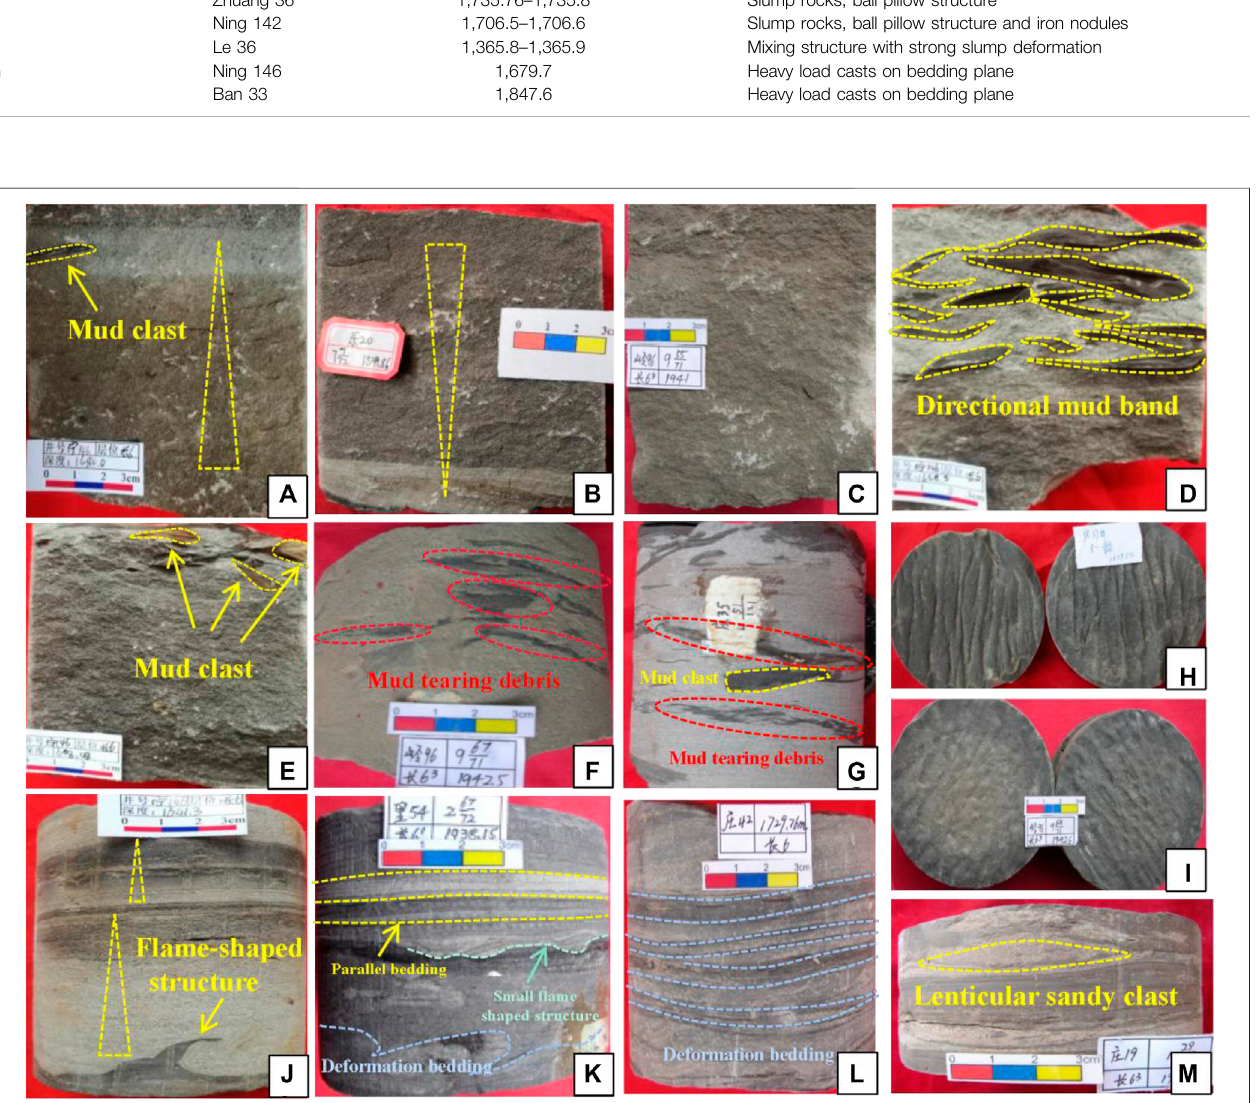
Frontiers in Earth Science |